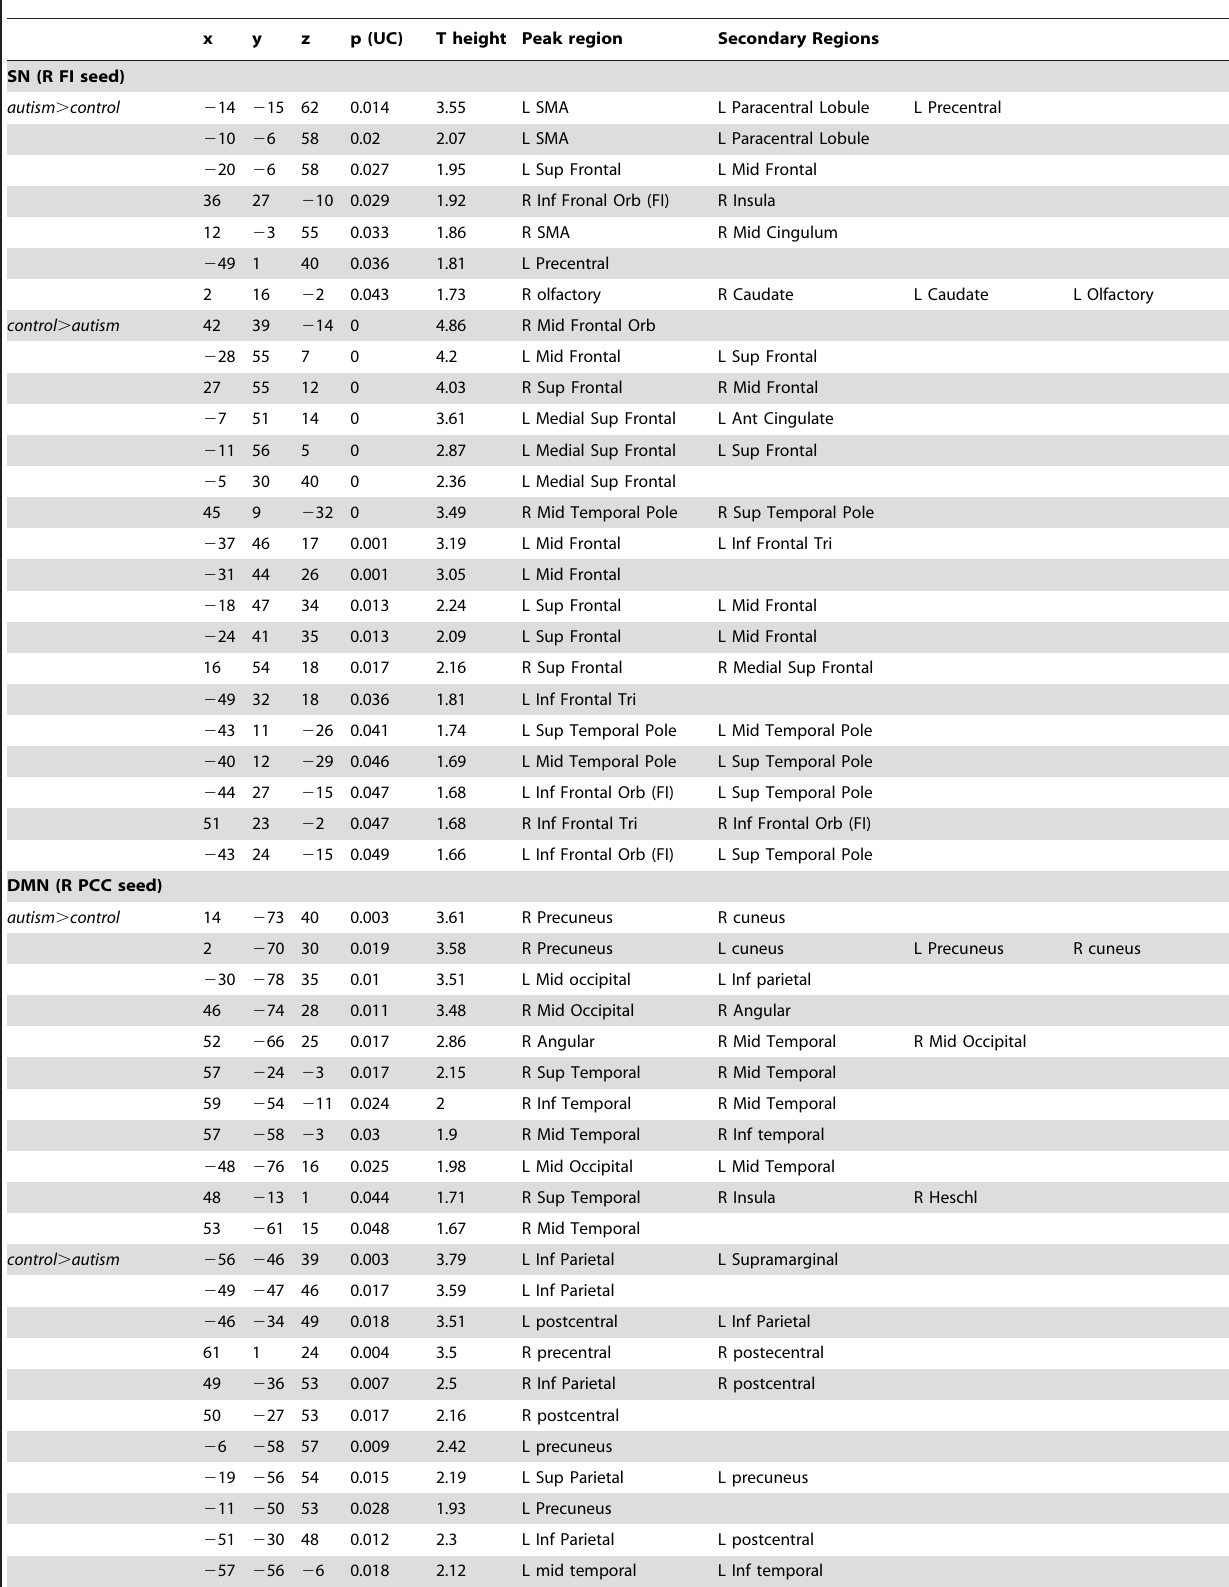
Table 3. MNI coordinates and characteristics of peak voxels and associated clusters of between-group scMRI maps.